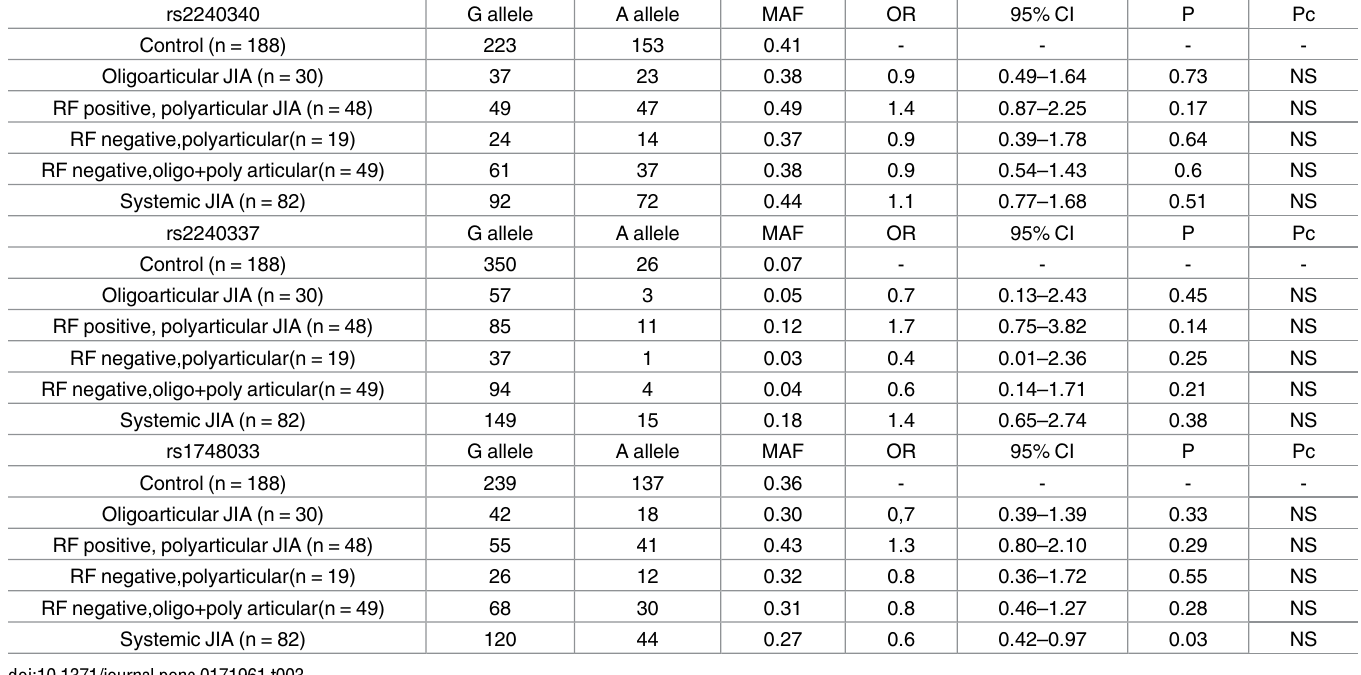
Table 3. Association between PADI4 gene polymorphisms and susceptibility to JIA subtypes.